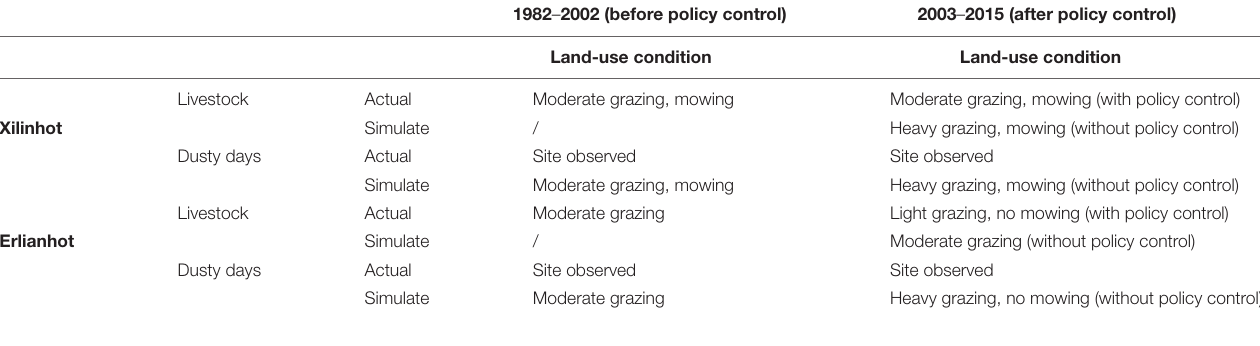
TABLE 3 | Scenarios of human influence simulation under different land-use conditions before and after dust policy